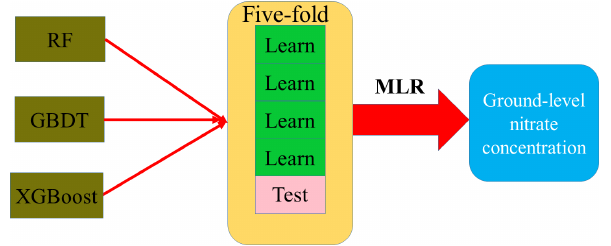
Figure 2. The workflow of the ensemble model development for ambient NO − 3